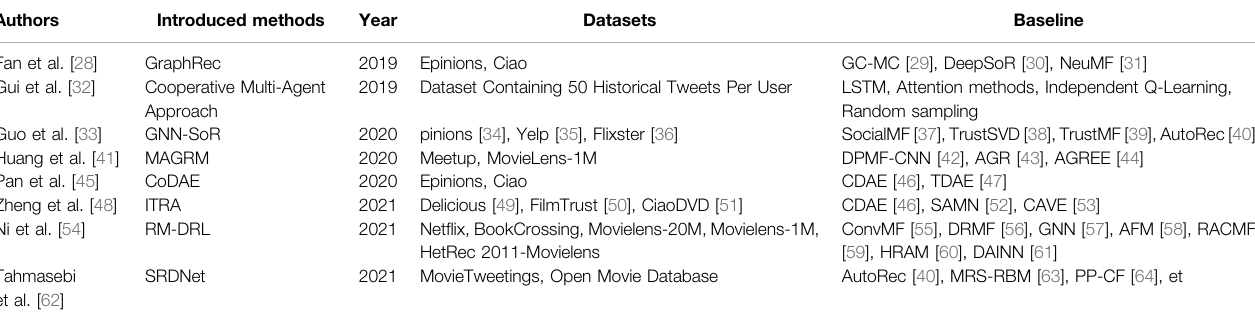
TABLE 2 | Maching learning in recommendation system.